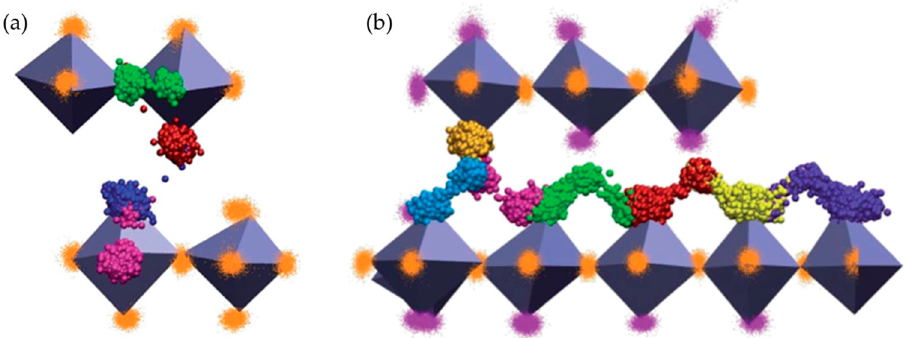
Figure 3. ( a ) 3D representation of oxygen vacancy migration between equatorial and apical positions within a CoO 6 octahedron (pink and red), between equatorial positions (green) and between apical positions belonging to separate layers (blue) in La 10.8 Sr 1.2 CoO 3.9 ; ( b ) 3D representation of oxygen interstitial migration in La 1.2 Sr 0.8 CoO 4.1 . Each oxygen involved in the migration event is represented by a different color. Spheres of the same color indicate the positions occupied by a specific atom over the simulation time. Reprinted from Ref. [79] with permission of The Royal Society of Chemistry.